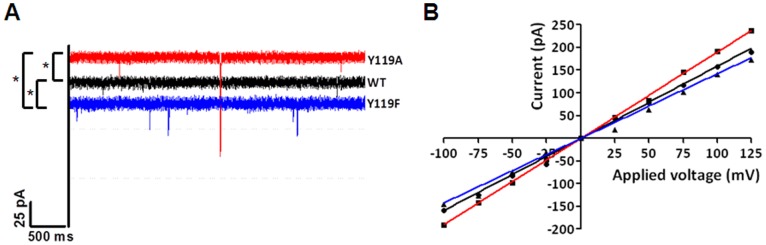
Single channel recordings of BpsOmp38 porin in artificial lipid membranes.Typical ion current traces of single BpsOmp38 variant channels in a fully open state at a transmembrane potential of +100 mM, (B) Current-voltage relationship of BpsOmp38WT in comparison with its two mutants. The current through a single open BpsOmp38 channel was monitored in 1 M KCl, following discrete changes in the voltage across the phospholipid membrane, from −100 to +125 mV. The slopes of a linear fit yielded the single channel conductances of individual BpsOmp38 channels. Data points for BpsOmp38WT, BpsOmpY119A and BpsOmpY119F are plotted as circles, squares and triangles, respectively. Differences in the three data sets were evaluated using one-way ANOVA. Statistically significant difference (P<0.05) is shown with an asterisk (*).